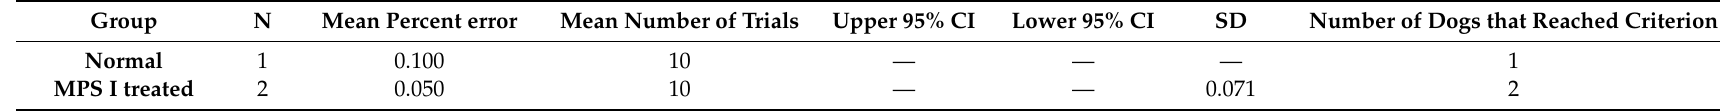
Table 7. DNMP descriptive statistics by group for 50-s delay. This includes the number of dogs tested (N) from each group, mean (real) percent error of each group, mean (real) number of trials performed by each group, 95% confidence interval, standard deviation, and number of dogs from each group that reached the criterion at the 50-s delay.